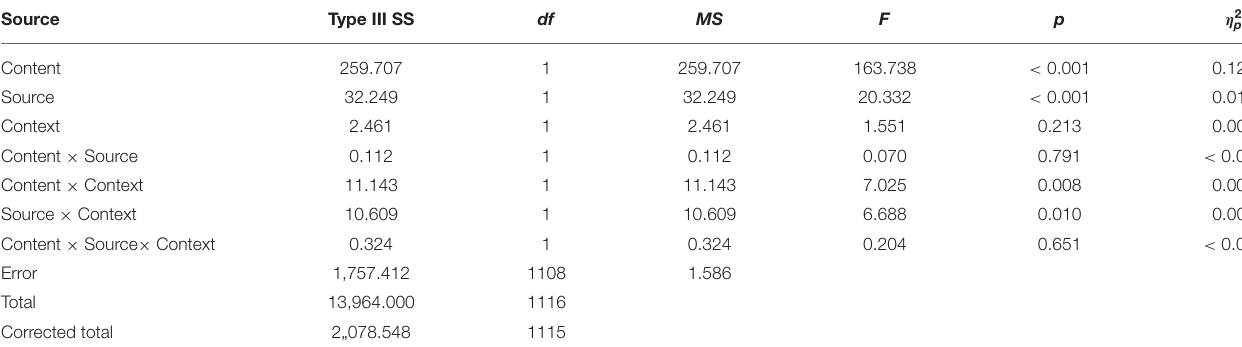
TABLE 4 | Analysis of variance results for the effect of social information on blood donation intention.